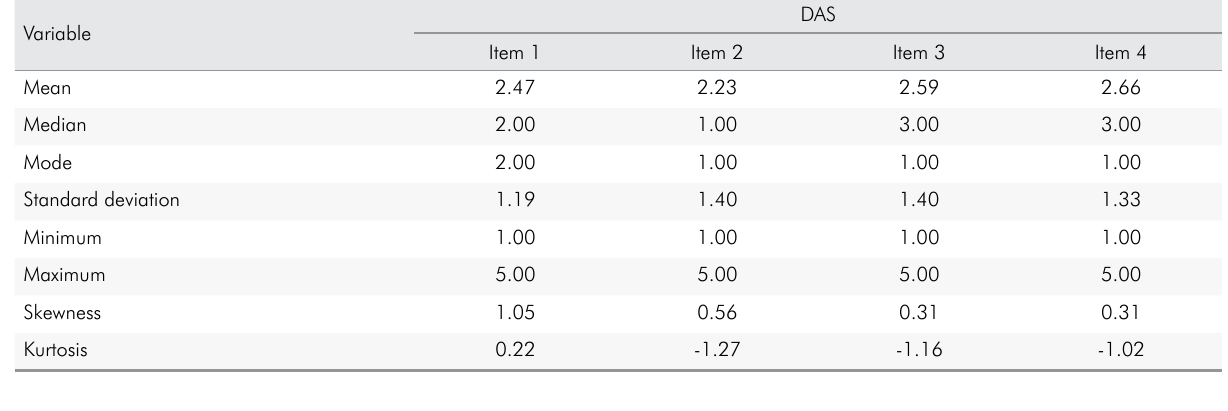
Table 2. Summary and shape measures of the Dental Anxiety Scale (DAS) item responses. Variable